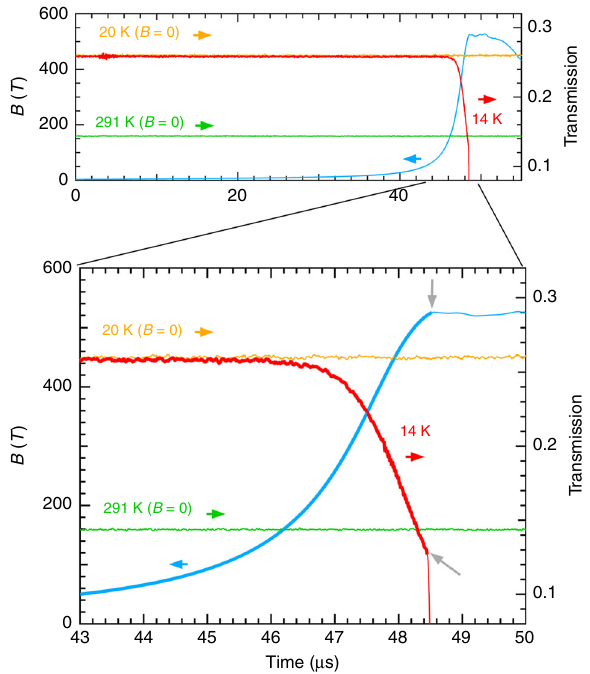
Fig. 3 Temporal evolutions of the magnetic fi eld and optical transmissions. Upper panel: evolutions of the magnetic fi eld (blue curve) and the optical transmission at 14 K (red curve). The temporal evolutions of the transmission at 20 K and 291 K before applying the magnetic fi eld are also shown with orange and light green curves, respectively. Lower panel: magni fi ed view of the upper panel. The two grey arrows show the breaking points of the measurements of the magnetic fi eld and optical transmission, respectively. They are found to occur at nearly the same time as the timing of termination of the magnetic- fl ux compression process 23 . The magnetic fi eld and optical transmission at 14 K after the breaking points are denoted with thin curves.